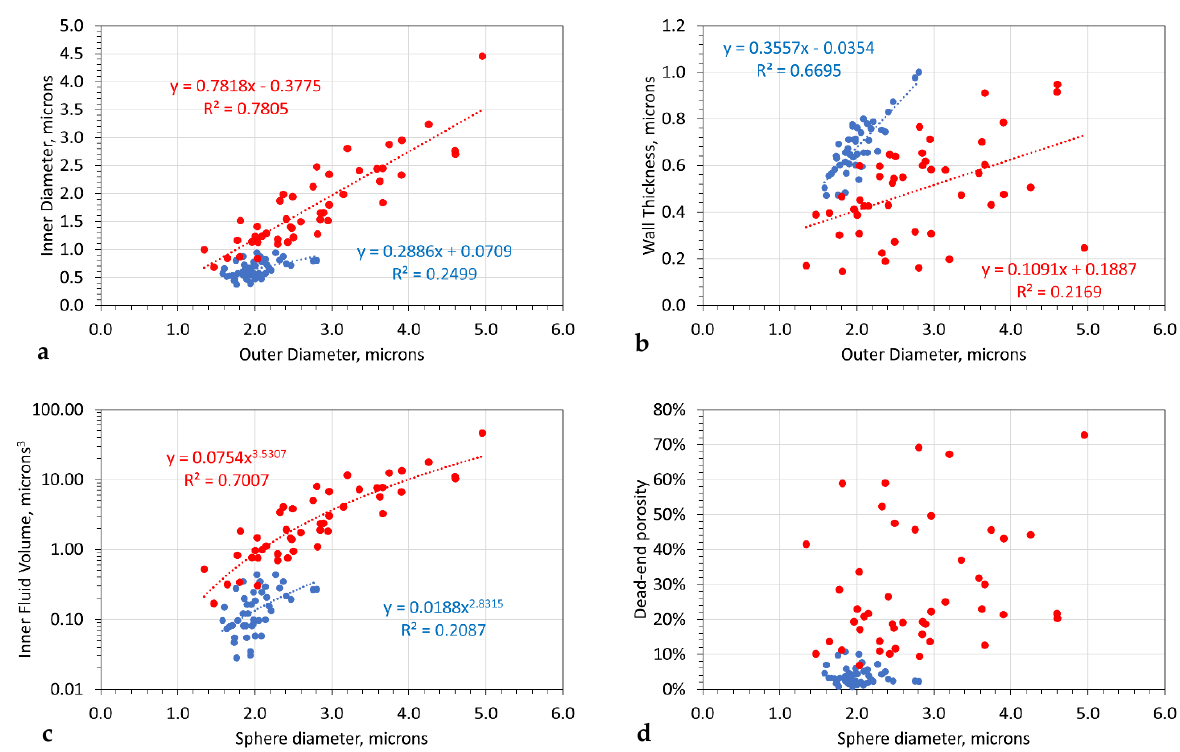
Figure 7. Colloidal spheres produced by n-Fe 0 (50 nm in diameter) in saline water. Blue = after 2 h; Red = after 4000 h ( a ) Outer diameter versus diameter of the fluid core; ( b ) outer diameter versus the wall thickness of the sphere; ( c ) sphere diameter versus volume of the fluid core; ( d ) sphere diameter versus total (percentage) fluid volume as a function of the sphere volume.